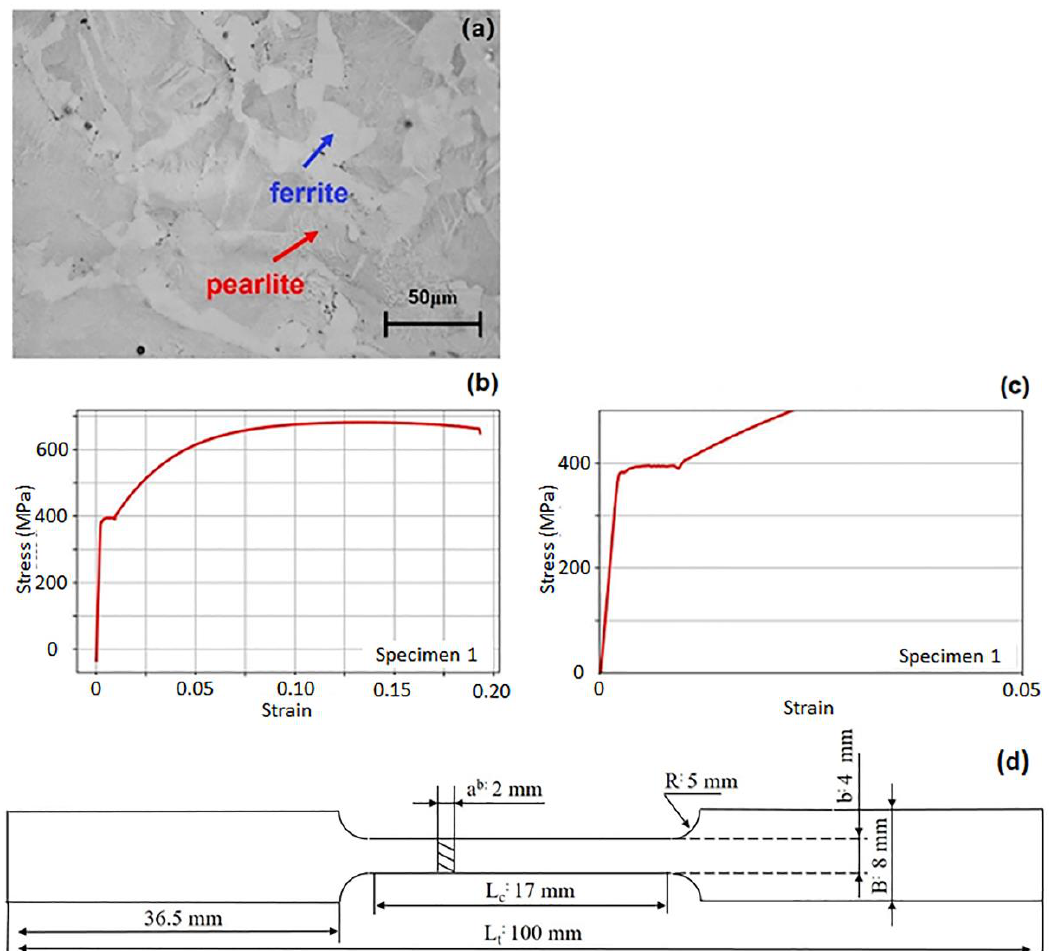
Figure 1. The ferrite-pearlite dual-phase microstructure, the stress-strain curve of the sleeper screw steel and tensile sample: ( a ) optical micrograph; ( b ) tensile stress-strain curve; ( c ) an amplified section from ( b ); ( d ) sketch of the flat dog-bone sample shape used for the tensile and fatigue testing.